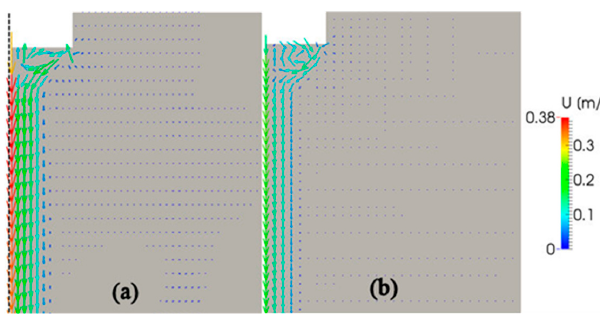
Figure 4. Predicted velocities of acoustic streaming in water ( a ) and molten aluminum ( b ).